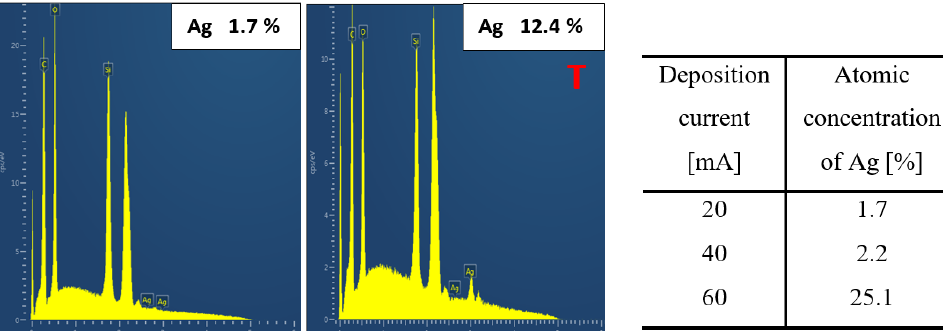
Figure 5. EDS spectrum of a sample deposited at 20 mA for 400 s, unheated 20 mA and 400 ( left ) and heated 20 mA and 400 ( right ), and a table with the atomic concentration of Ag of the prepared samples at a sputtering time of 400 s at different currents (20, 40, and 60 mA).